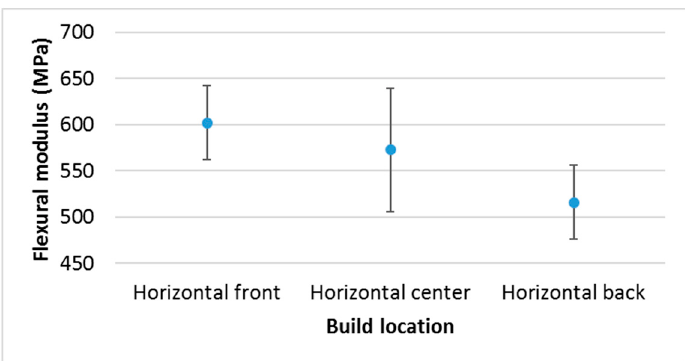
Figure 3. Castable resin in Projet 1200. Different build locations on the platform. Table 3. Statistical study for resin Castable Blend in system DLP Projet 1200.